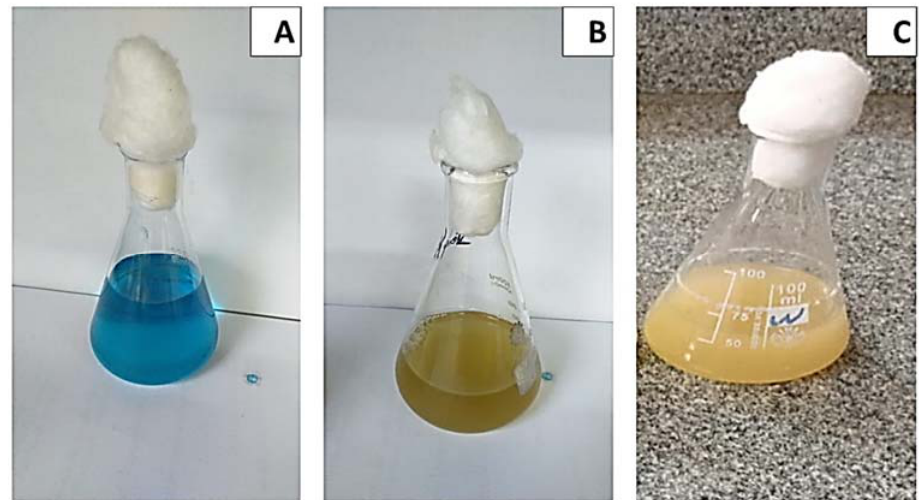
Figure 3. Effect of incubation time on growth kinetics and MG decolorization using S. exfoliatus incubated at 30 °C for 144 h. ( A ) MG color at zero time of incubation 30 °C for 144 h. ( B ) MG color at 72 h of incubation 30 °C for 144 h. ( C ) MG color at 144h of incubation at 30 °C for 144 h.